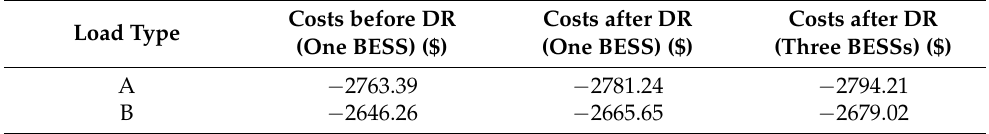
Table 4. Comparison of the total operation costs in terms of DR implementation and different quantities of BESSs (the distribution operator cannot sell electricity to the utility grid). Costs before DR Costs after DR Costs after DR Load Type (One BESS) ($) (One BESS) ($) (Three BESSs) ($) A − 2763.39 − 2781.24 − 2794.21 B − 2646.26 − 2665.65 −